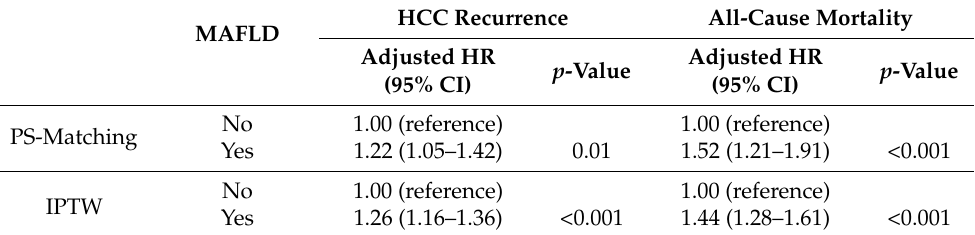
Figure 2. Cumulative incidence plots of postoperative HCC recurrence ( a ) and all-cause mortality ( b ) stratified by MAFLD after PS-matching analysis. Table 3. Multivariable analyses of HCC recurrence and all-cause mortality according to MAFLD among patients with HBV-related HCC receiving surgical resection after PS-matching or